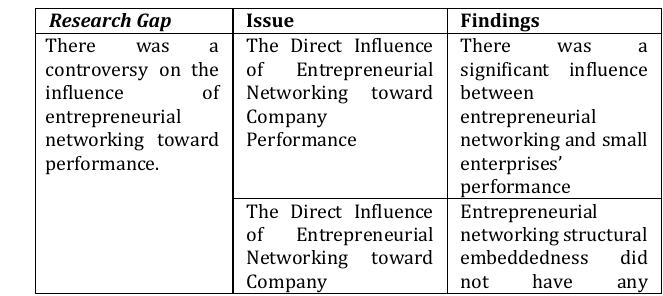
Table 1: Research Gap, The Relationship Between Entrepreneurial Networking, With